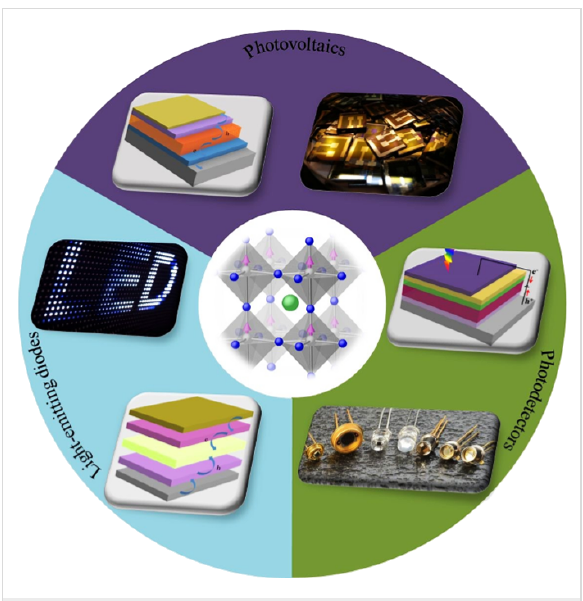
Figure 1: Schematic diagram showing an OIHP crystal (center) and its applications in various optoelectronic devices such as photovoltaics, light-emitting diodes and photodetectors. Reproduced with permission from [63], copyright 2019 Royal Society of